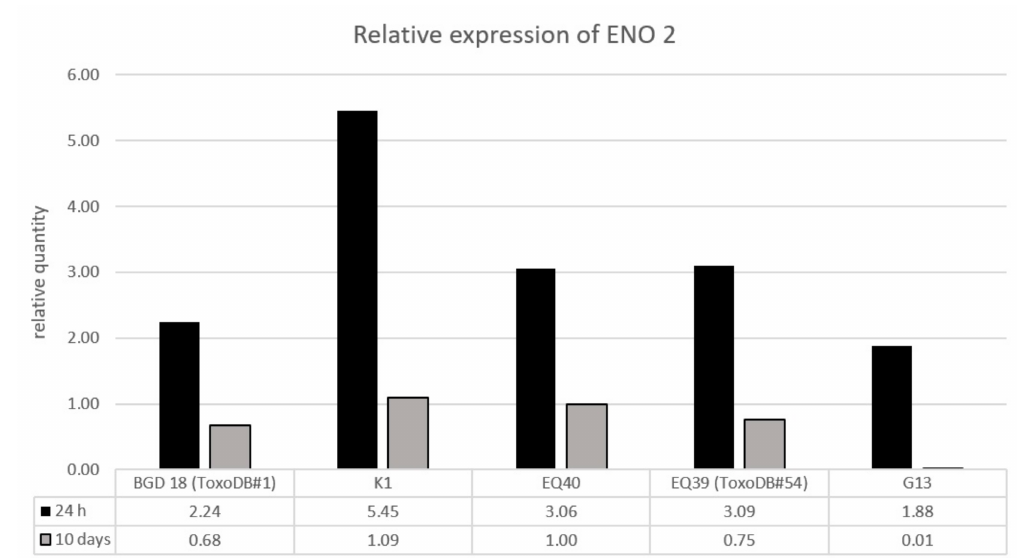
Figure 5. Relative quantification ( ∆∆ Ct) of ENO2 after 24 h and 10 days of in vitro